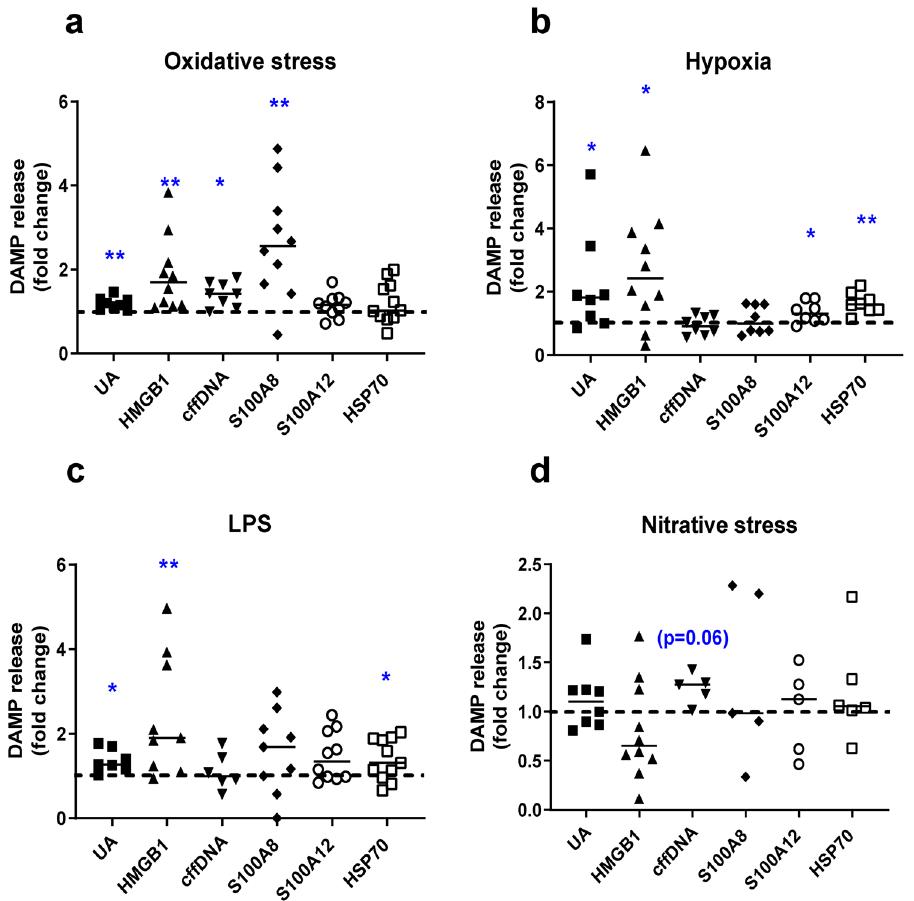
Figure 1. Effect of placental insults on release of DAMPs by term placental explants. Explants were exposed for 72h to ( a ) oxidative stress (1 mM H 2 O 2 ), ( b ) hypoxia (1%O 2 ), ( c ) low dose LPS (1 ng/ml to mimic subclinical infection), ( d ) nitrative stress (1 mM SIN-1). Concentrations of uric acid (UA), high mobility group box 1 (HMGB1), cell free fetal DNA (cffDNA), S100 calcium binding proteins A8 (S100A8) and A12 (S100A12), heat shock protein 70 (HSP70) were measured in culture medium and corrected for explant protein content. Data are fold change from control conditions (n = 5–11, line represents median); dashed line represents control values. * p < 0.05, ** p < 0.01 Wilcoxon signed